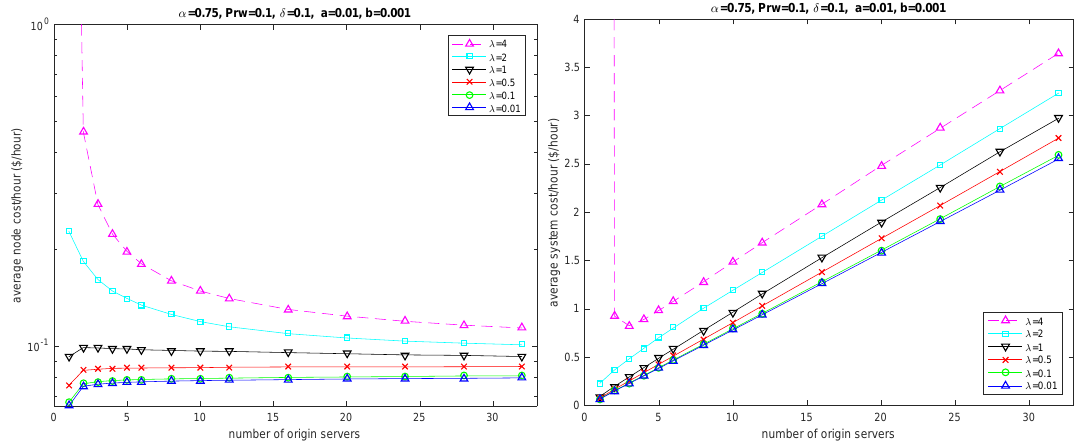
Figure 6. Cost impact of the number of servers; per node hourly cost ( left ); system hourly cost ( right